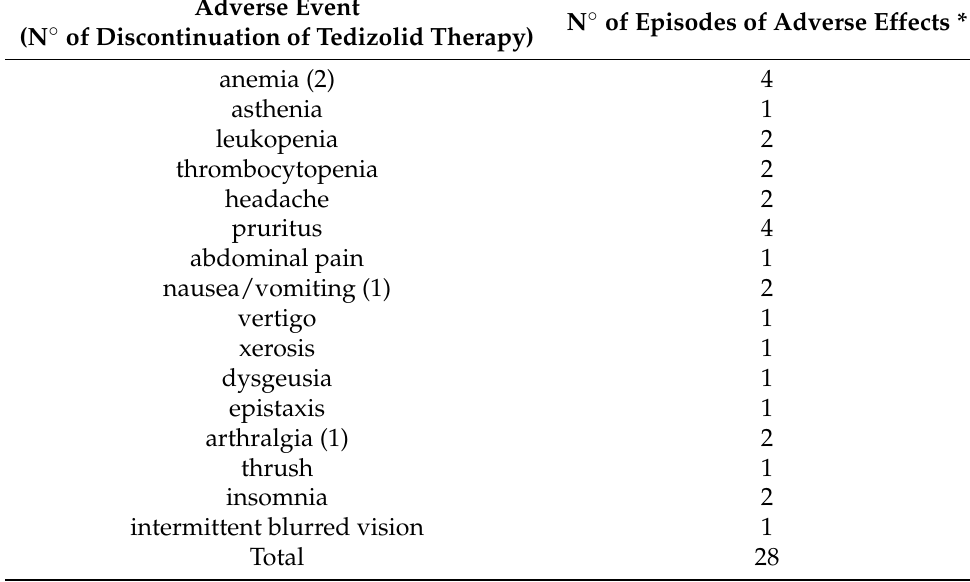
Table 3. Episodes of adverse effects reported in 33 patients during tedizolid